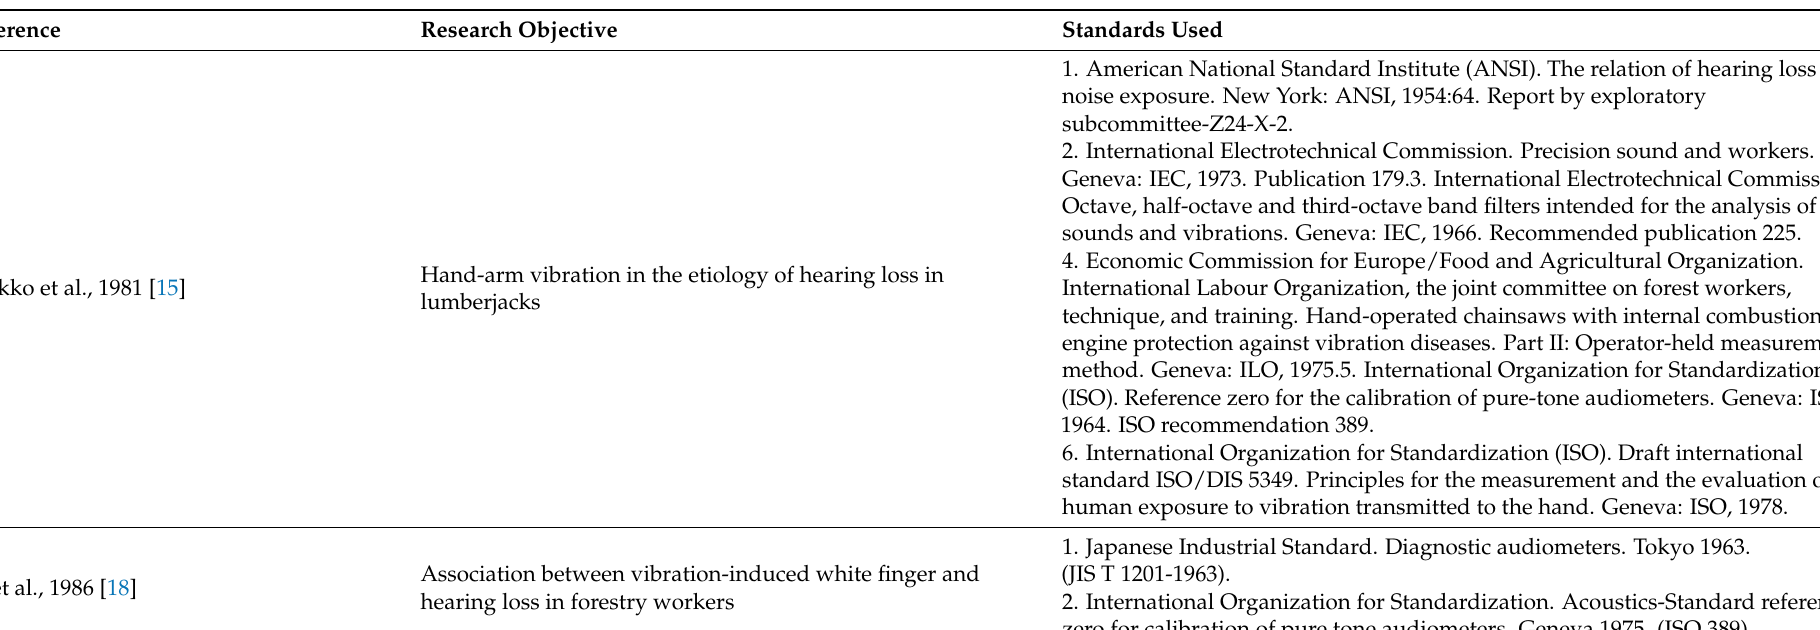
Table 2. Standards followed in each study (NM—Not Mentioned, WBV—Whole Body Vibration, HAV—Hand Arm